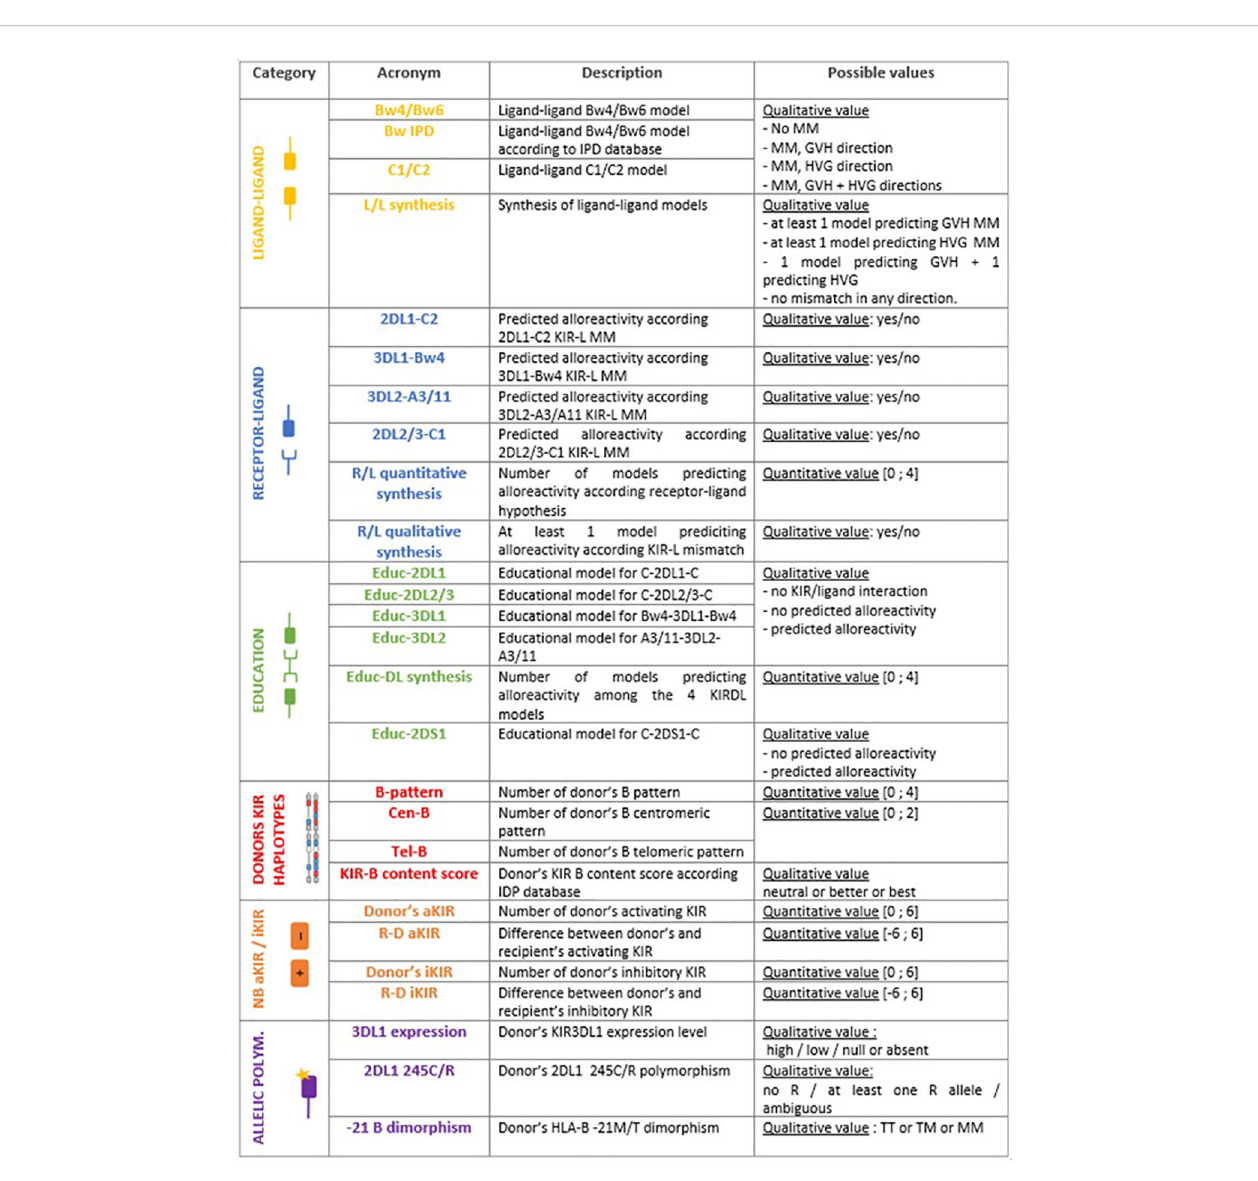
FIGURE 2 Acronyms used in this paper, short description of each model and possible values of alloreactivity